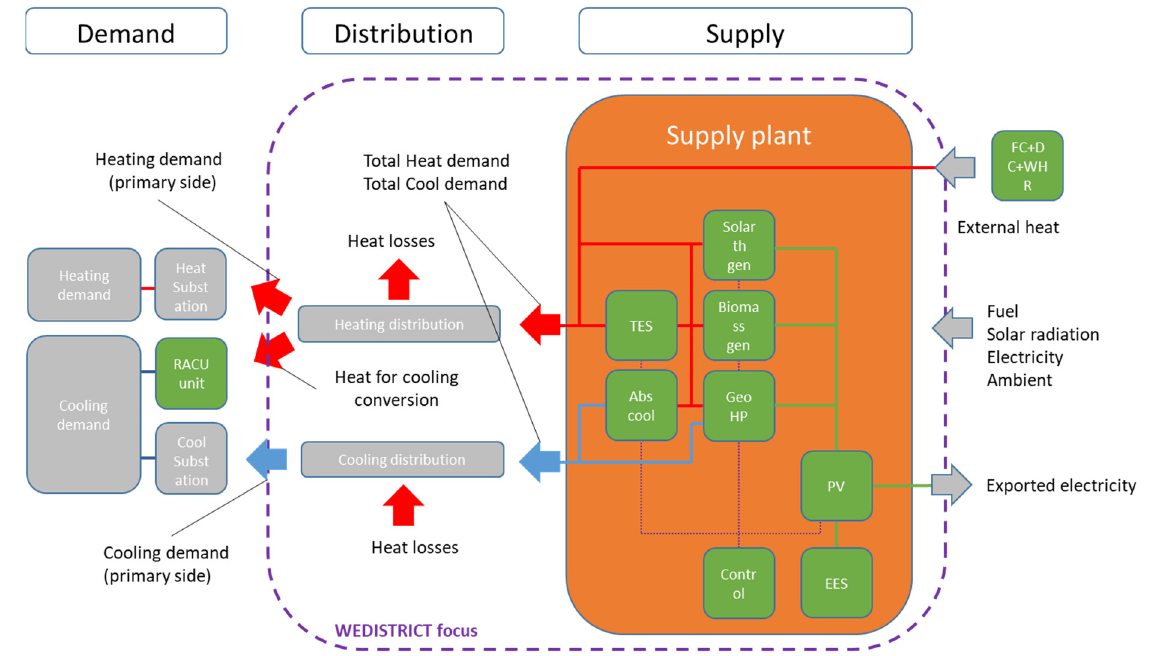
Figure 2. System boundaries example used for analysis of WEDISTRICT projects [18].